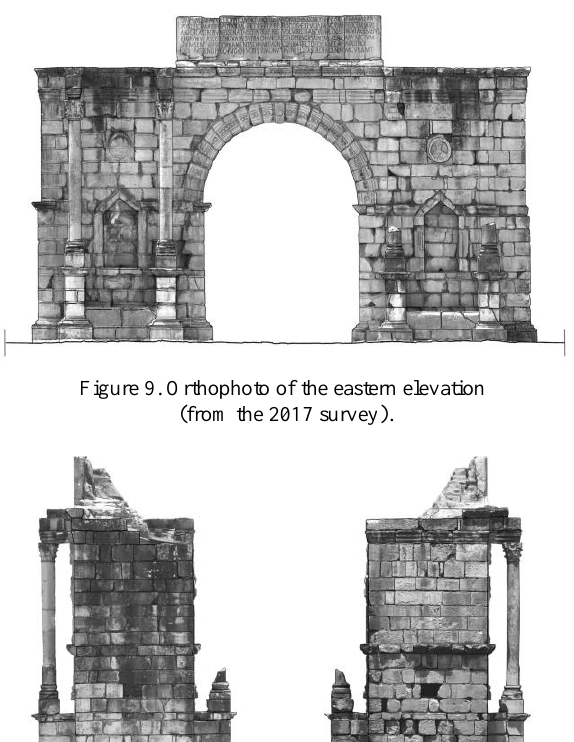
Figure 6. Eastern elevation (from the 2017 survey).